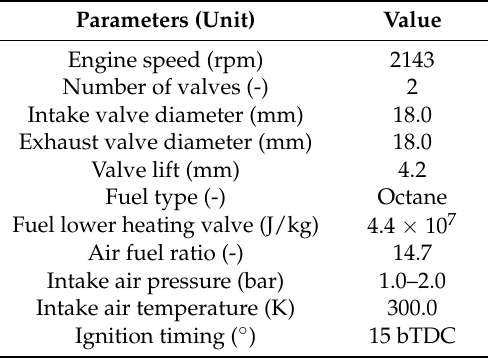
Table 2. Simulation engine input parameters.